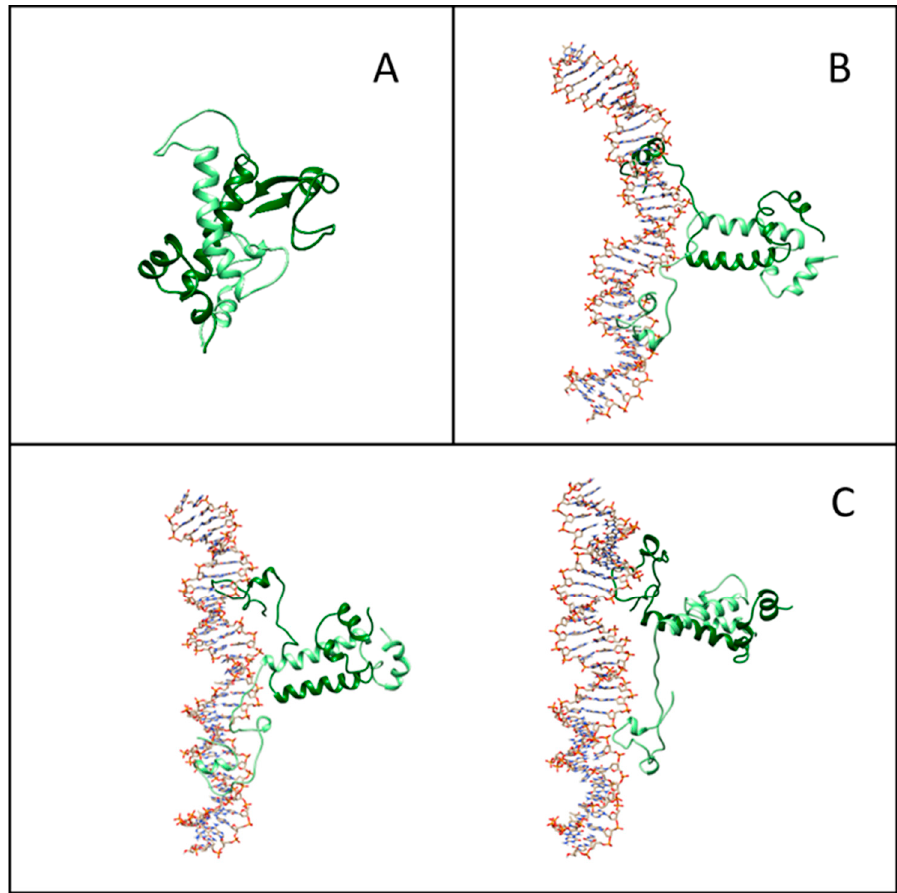
Figure 5. Representative structures from molecular simulations. ( A ) Equilibrated structure of isolated Gal4. ( B ) Snapshot of the structure of the Gal4–DNA complex in the presence of the specific DNA sequences. ( C ) Examples of structures of the Gal4–DNA complex in the absence of the specific DNA sequences.